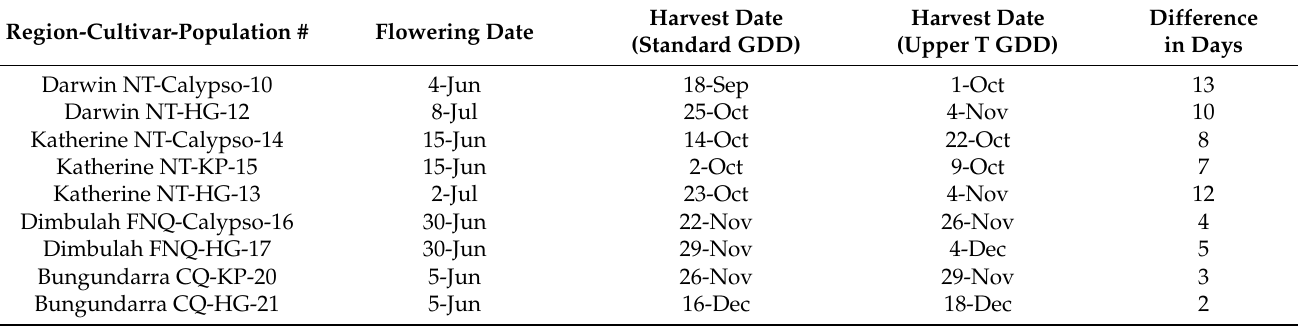
Table 5. Data showing 2021/22 harvest date estimated from flowering date using the standard and the Upper T methods of calculating GDD for 9 populations, varying in location and cultivar. GDD (from asparagus stage, Tb = 12 ◦ C, TB = 32 ◦ C) targets of 1680 for Calypso, 1800 for Honey Gold (HG) and 1600 for Kensington Pride (KP) were used.